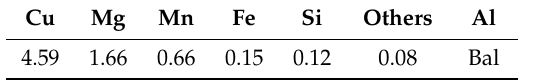
Table 1. A2024 alloy composition (mass %).